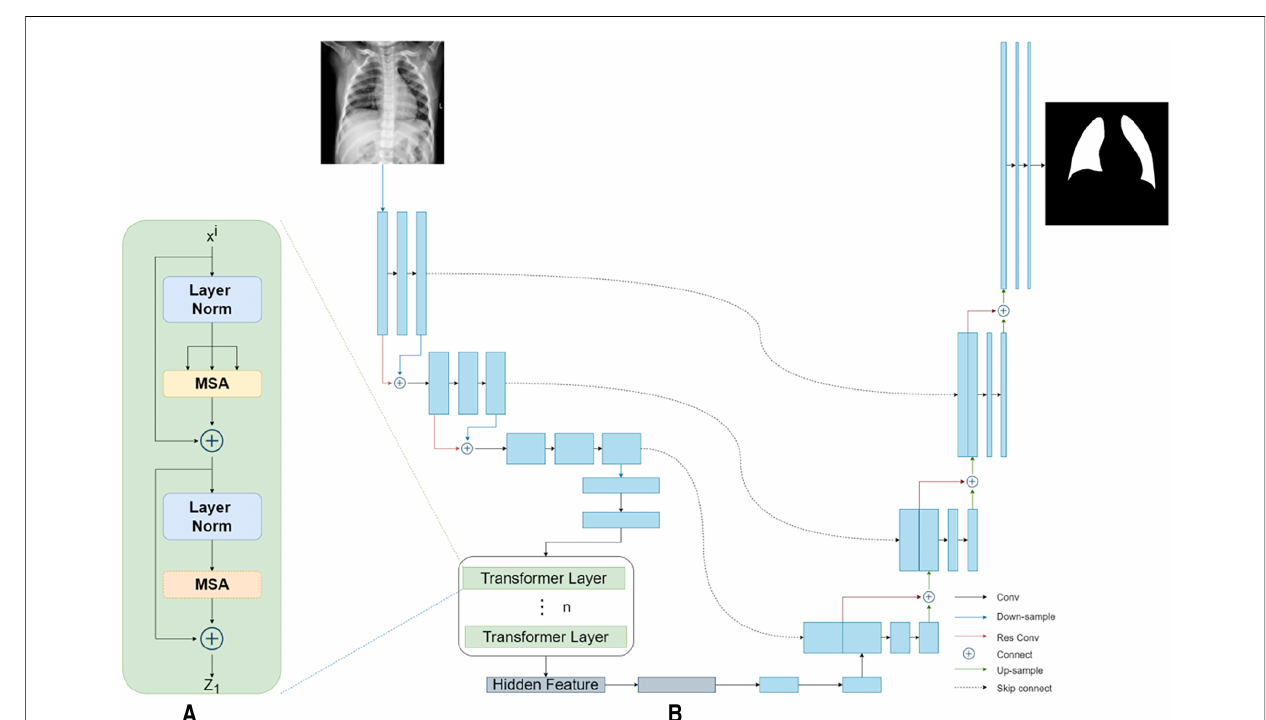
FIGURE 2 The architecture of TransResUNet. ( A ) Depicts the deconstruction schematic of Transformer Layer. ( B ) Depicts the proposed